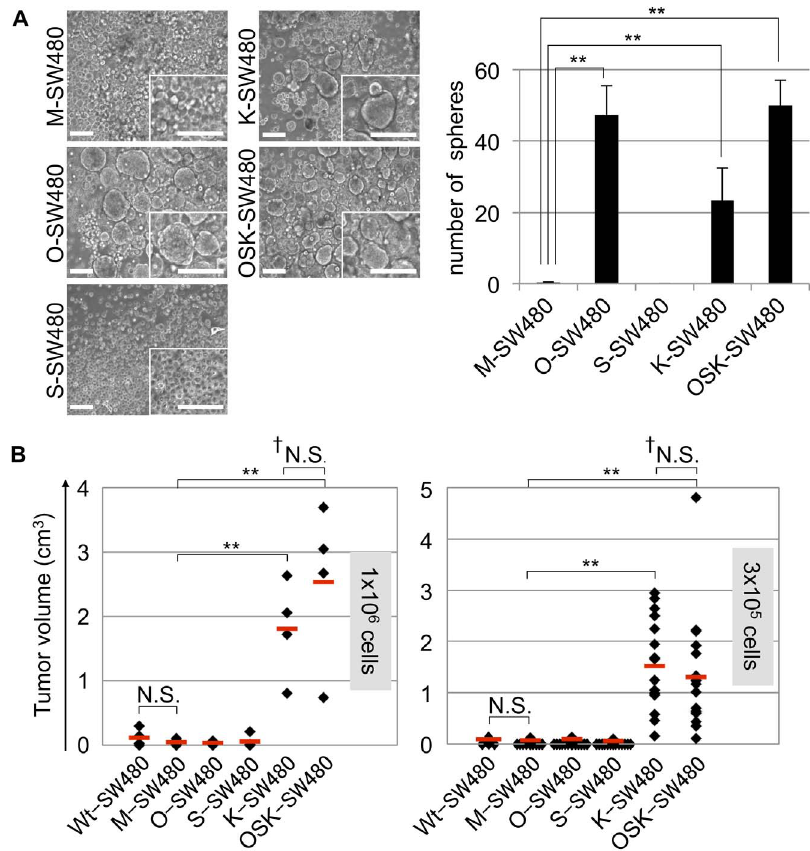
Figure 2. The sphere formation ability invitro and tumorigenicity invivo . (A) The spheroid formation assay. A total of 1 6 10 4 cells were plated on low attachment dishes on day 10 and cultured with serum-free medium for 10 days. In the O-, K- and OSK-SW480 cultures, the number of spheroids was significantly increased compared to that of the M-SW480 cells. The error bars indicate the SD (n=3). Scale bars: 100 m m. (B) The tumorigenicity of the cells after implantation in the subcutaneous regions of immunodeficient nude mice. A total of 1 6 10 6 cells (left panel) or 3 6 10 5 cells (right panel) were subcutaneously injected into both flanks of immunodeficient nude mice on day 10. The volume of the tumors derived from the K- and OSK-SW480 cells were obviously higher than those of the Wt-, M-, O- and S-SW480 cells for both numbers of injected cells. The red bars indicate the median tumor volume. **P , 0.01, N.S.: not significant, Dunnett’s test (except of { : U-test).